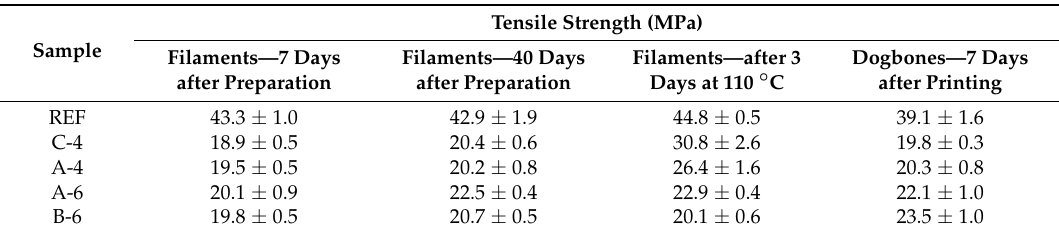
Table 4. Tensile strength (MPa) of measured PHB/PLA/plasticizer samples and PHB/PLA reference.